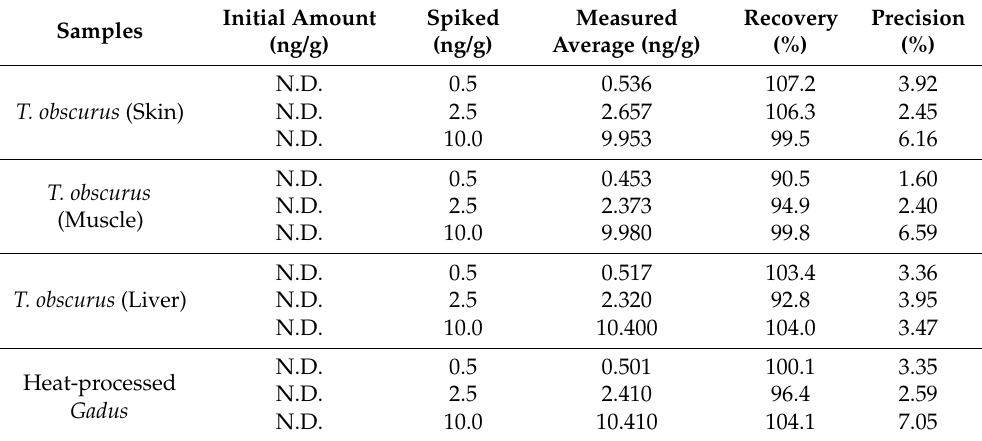
Table 4. The determination of TTX in T. obscurus and heat-processed Gadus based on the estab- lished